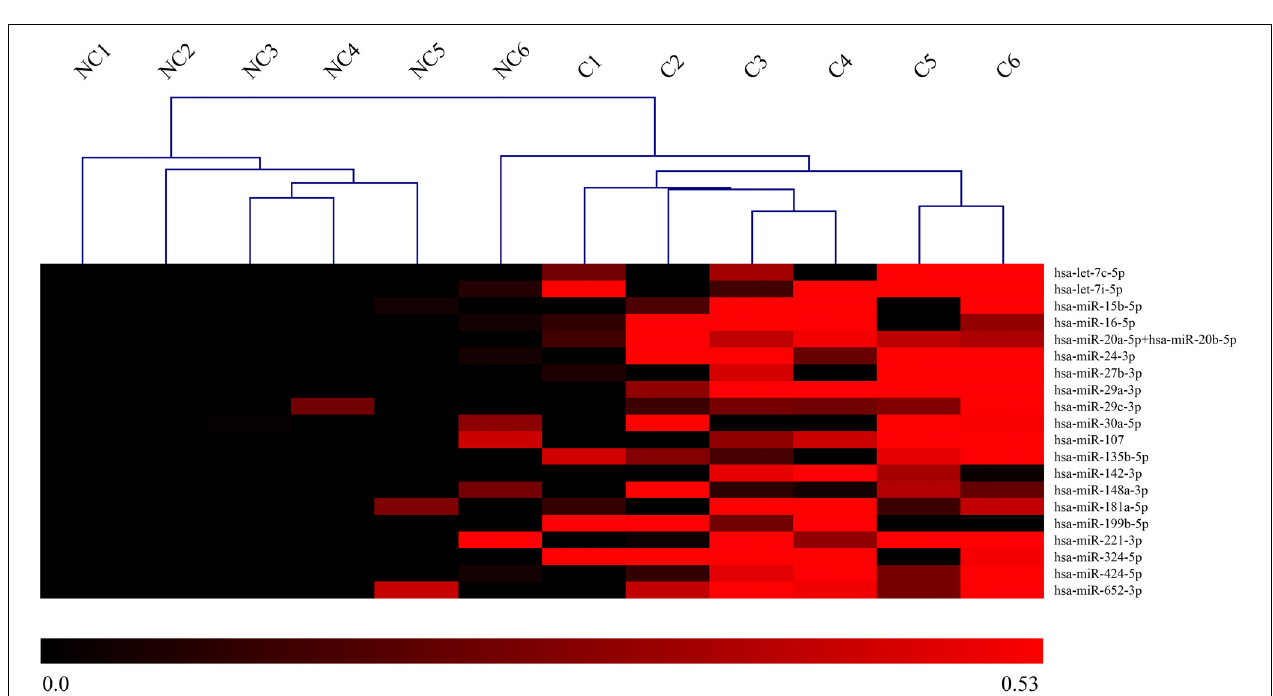
FIGURE 2 | Heat-map of DE-miRNAs in saliva of concussed and non-concussed athletes. Heat-map of the miRNAs differentially expressed in saliva of concussed and non-concussed athletes. The values of log2 fold changes for each miRNA are color coded, as shown in the colored bar. Sample clustering obtained through hierarchical clustering approach is shown. NC, non-concussed athletes; C, concussed athletes.